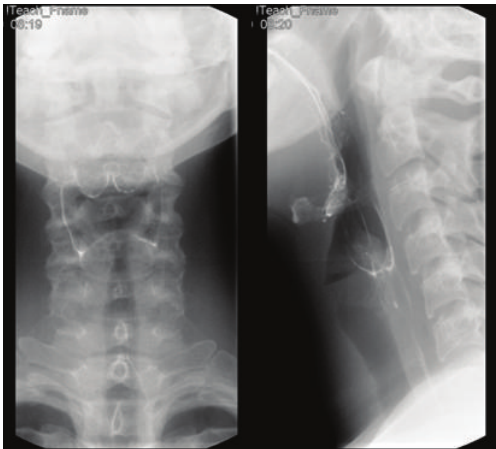
Figure 4: Laryngeal forceps used to insert TCA-soaked micropled- get into fistulous tract.